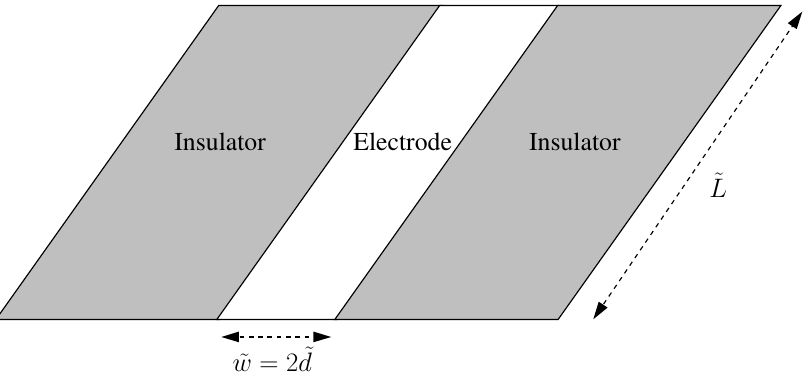
Figure 1. Cartoon of an inlaid microband electrode of width ˜ w = 2 ˜ d and length ˜ L .